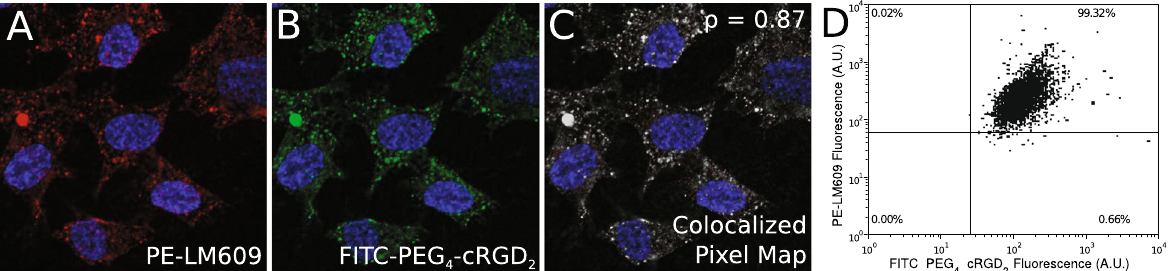
Figure 3. Colocalization between phycoerythrin-labeled anti- α V β 3 integrin primary antibody (PE-LM609) and FITC-labeled PEG 4 -cRGD 2 probe. Human umbilical vein endothelial cells (HUVEC) were grown to confluency and incubated with both PE-LM609 and FITC-PEG 4 -cRGD 2 . Fluorescence microscopy images were acquired in DAPI/PE ( A ) and DAPI/FITC ( B ) channels and were superimposed to create colocalized pixel map ( C ) to calculate Pearson’s coefficient. Flow cytometric analysis of HUVEC co-incubated with PE-LM609 and FITC-PEG 4 -cRGD 2 demonstrated a very high degree of colocalization between integrin α V β 3 and FITC-PEG 4 - cRGD